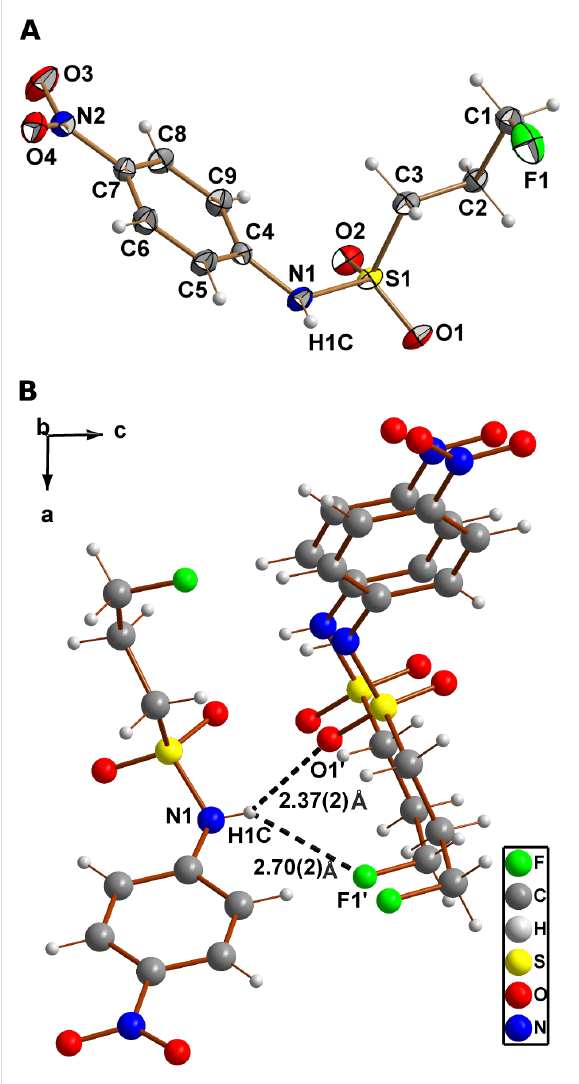
Figure 2: ( A ) View of the molecular structure of sulfonamide 18 with atom labelling scheme. Displacement ellipsoids are drawn at the 50% probability level. ( B ) View of the arrangement of molecules in crystals of sulfonamide 18 showing hydrogen-bond contacts of the amide H-atom H1C.